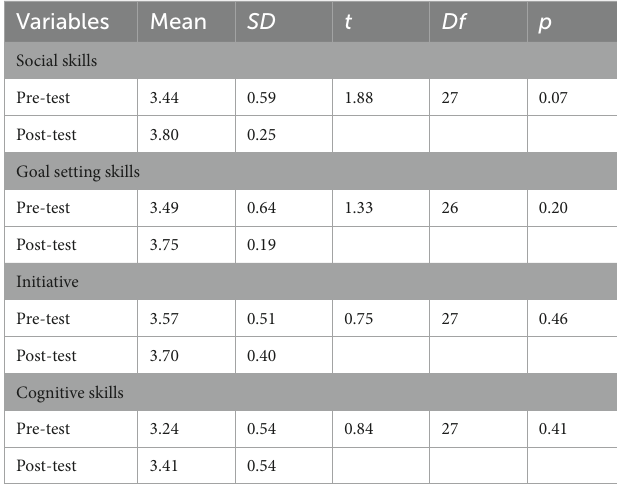
TABLE 1 Pre-test and post-test analysis on entrepreneurship